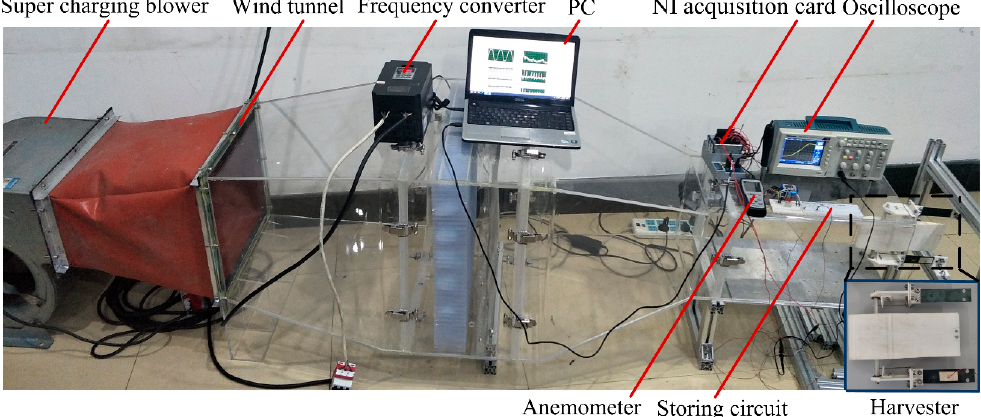
Figure 2. Wind-tunnel experimental system.